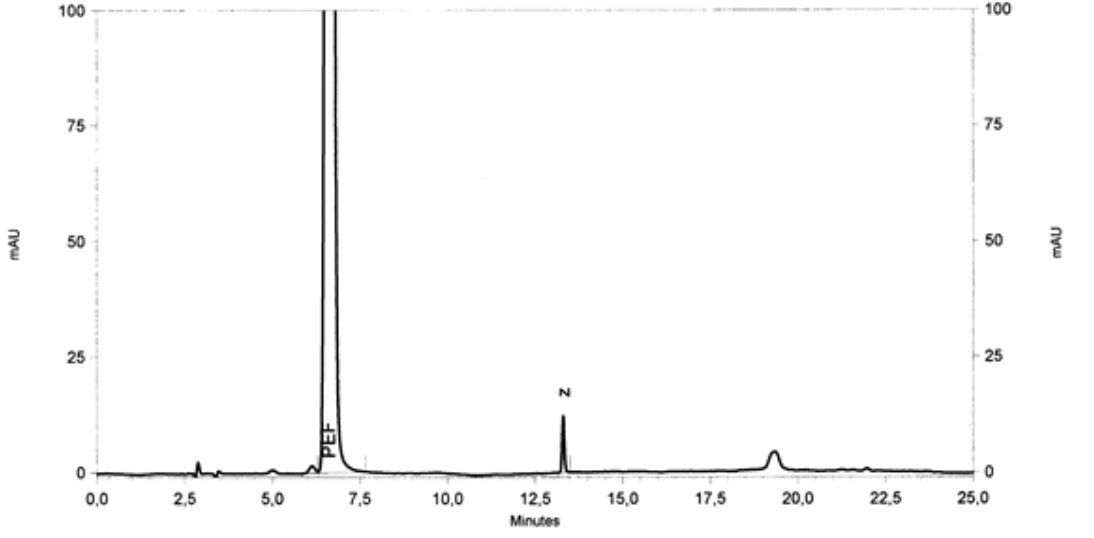
Figure 2. Chromatogram of PEF standard solution at a concentration of 0.5 mM recorded at 277 nm.